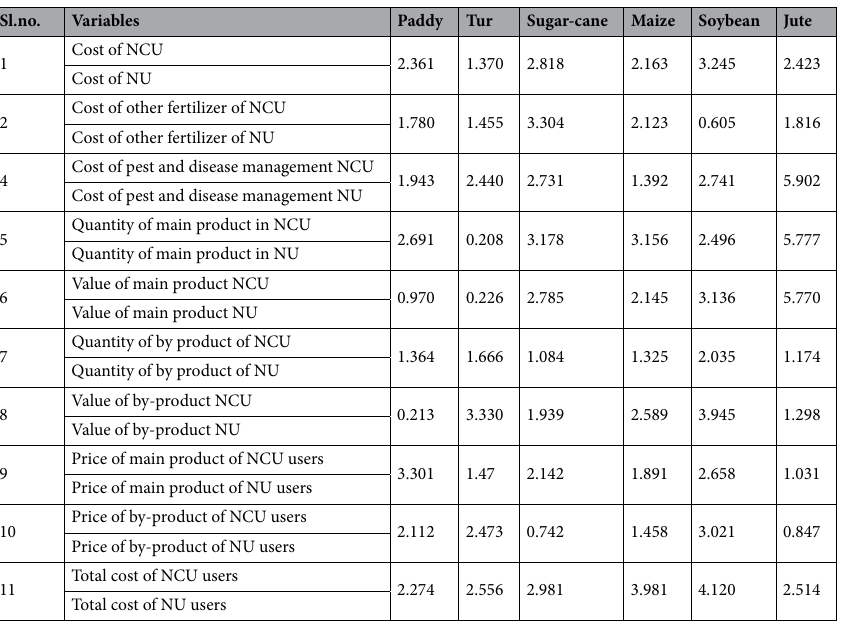
Table 9. Crop-wise results of t-values two sample paired t-tests with unequal variance. Source: Authors’ estimates using field survey data.